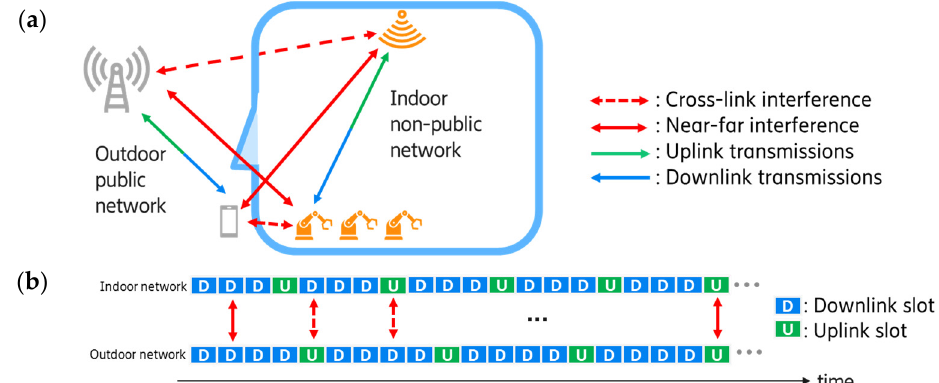
Figure 1. Illustration of interference situation caused by coexisting indoor and outdoor networks. ( a ) Interference links between base stations and UEs of indoor and outdoor networks when different TDD patterns are selected. ( b ) Different TDD patterns used in the indoor network compared to the outdoor network result in both near–far interference and cross-link interference.